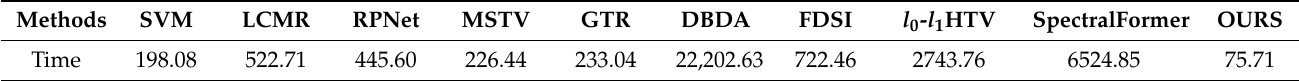
Figure 4. Houston University 2018. ( a ) False color composite image; ( b ) Ground truth image; ( c ) SVM; ( d ) LCMR; ( e ) RPNet; ( f ) MSTV; ( g ) GTR; ( h ) DBDA; ( i ) FDSI; ( j ) l 0 - l 1 HTV; ( k ) SpectralFormer; ( l ) Our method. Color illustrations of all classes are shown below.